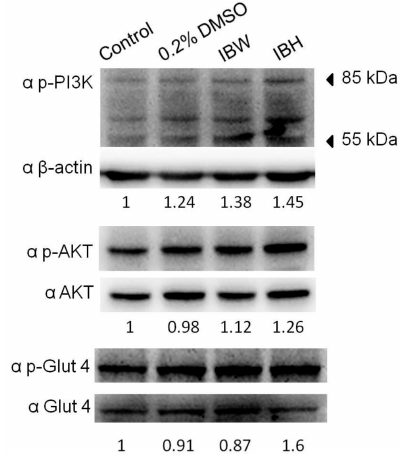
Figure 3. The effects of extracts on PI3K/AKT/Glut4 expression in mature 3T3-L1 adipocytes. Cells were treated with 0.1 mg/mL of IBW and IBH crude extracts for 24 h, and then analyzed for PI3K, AKT, Glut4, and β -actin by western blot analysis.